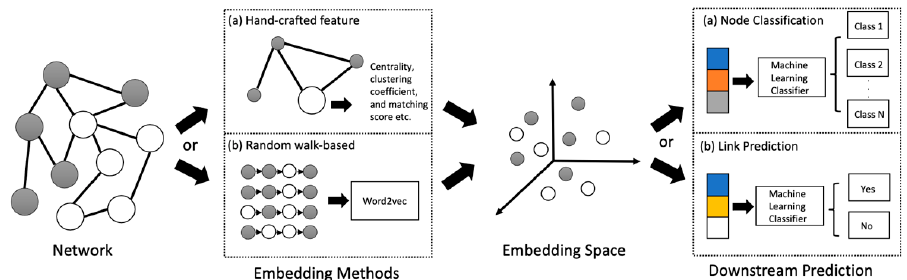
Figure 3. Shallow embedding methods. Graph-embedding methods extract low-dimensional node representations from the network, which are then used as features to train specific classifiers for node classification or link prediction. For (a) hand-crafted approaches, the features generated by the network are used as input to train machine-learning models. For (b) random walk-based techniques, random walks are utilised to generate node sequences. Afterwards, these sequences were fed into the word2vec [26] to extract node